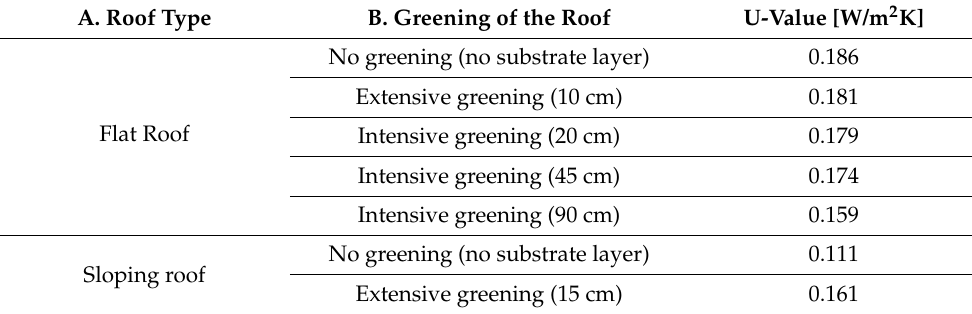
Table 3. Overview: Buildings extensions with different green roof types